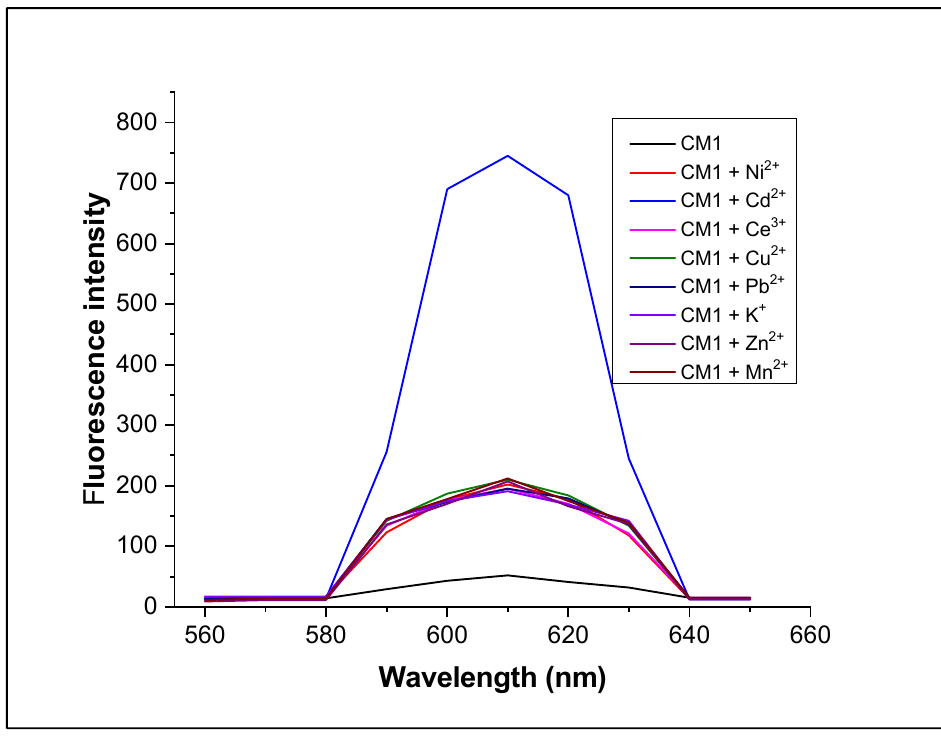
Figure 3 . Initial fl uorescence study CM1 (10 µM) and metal ions (200 µM), at λ ex = 390 nm and λ em= 610 nm